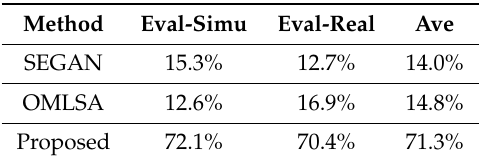
Table 2. Subjective preference evaluation results of the compared methods on 100 noisy speech utterances evaluation